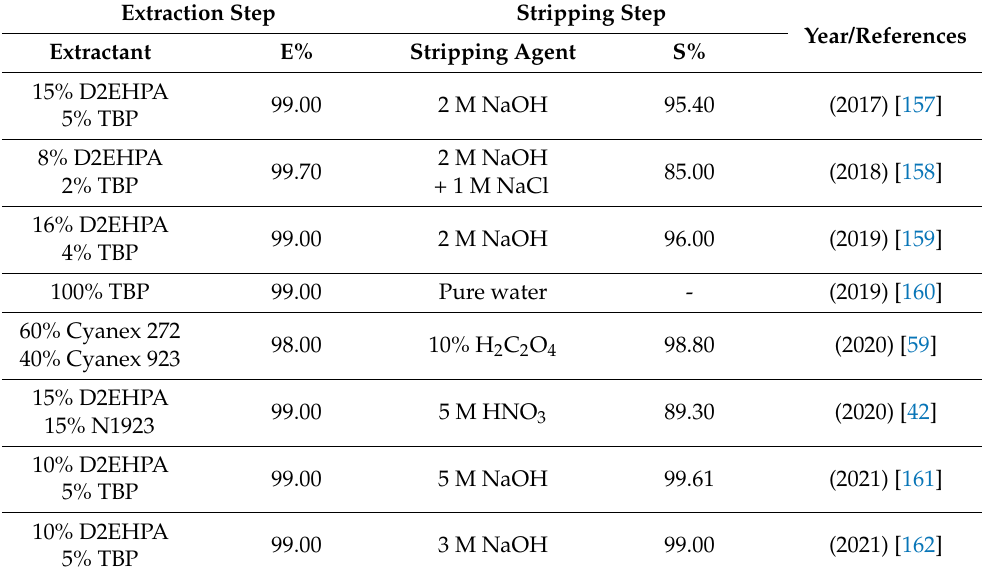
Table 3. Comparison of solvent extraction by OPCs for Sc recovery from red